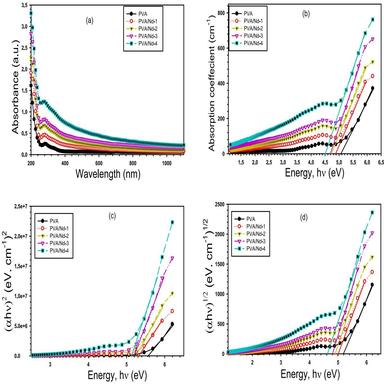
(a) Absorbance A with λ, (b) α with hν, (c) band gap with hν and (d) ln(α) with hν for PVA and PVA/Nd2O3.